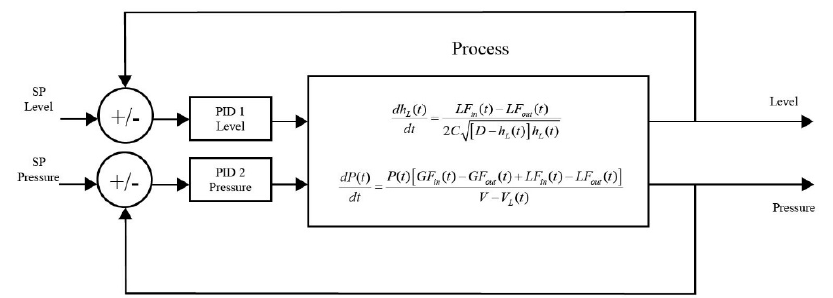
Figure 5. PID control loop implementation diagram .